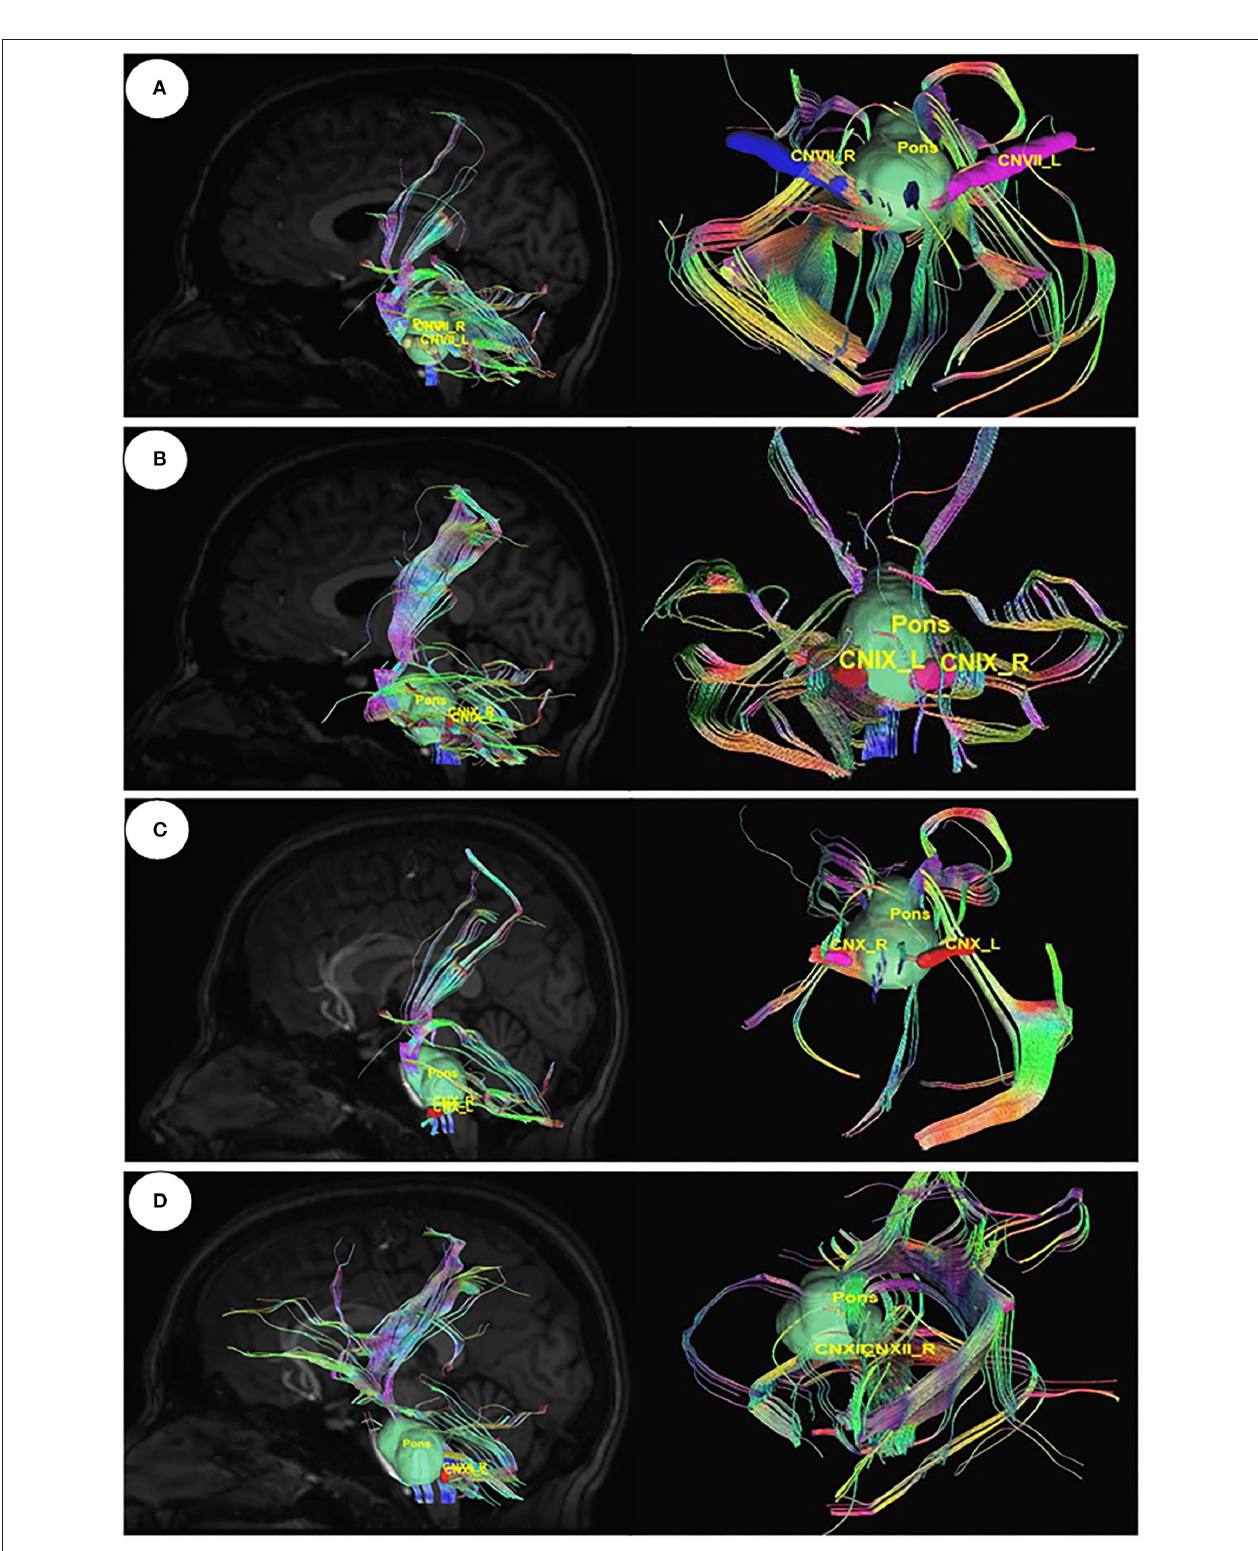
FIGURE 3 | Diffusion MRI fiber tracking-connecting pons with the gustatory nerves. (A) pons to cranial nerves VII, (B) pons to cranial nerves IX, (C) pons to cranial nerves X, and (D) pons to cranial nerves XII.